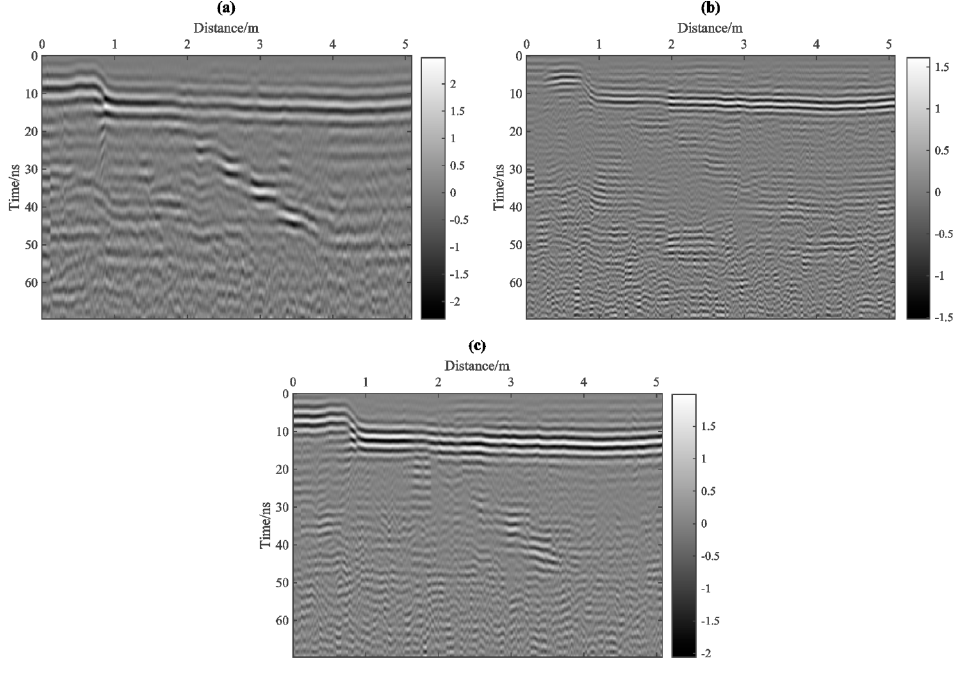
Figure 14. IMF-slices of the field data using MVMD. ( a − c ) show the IMF-slices 1 − 3, respectively. Based on the above IMF-slices, we derive the corresponding instantaneous amplitude profiles and TKEO-slices, as seen in Figures 15 and 16, where the phenomenon of the “low-frequency anomalies” can be observed. Specifically, the low - frequency TKEO - slice (i.e., Figure 16a) highlights the horizontal layers and voids and, in the medium - and high - frequency TKEO-slices, the energy for the voids gradually decays until it becomes very weak, as seen in Figure 16b,c. Figure 15 a–c are the classical instantaneous amplitude at- tributes for the IMF-slices showing the similar features in lower resolution. It is obvious that the TKEO-slices are less disturbed by the noise and multiple reflections at the deep part of the profiles, which show better performance in gathering the energy at the location of voids. For comparative analysis, we apply the VMD to each A − scan of the field data, and then collect the IMFs of same order into three IMF-slices ( K = 3), as seen in Figure 17. The drawback of the trace − by − trace decomposition scheme is obvious, e.g., the discontinuity between adjacent traces due to misaligned frequency modes, marked by the red arrows between 3~4 m. The results of the TKEO computation based on the VMD − based IMF-slices are shown in Figure 18, where the resolution and lateral continuity is affected by the in- complete decomposition of VMD. The above application on the field data shows that the proposed method has an obvious response to the anomaly targets in the subsurface me- dium, and proves the effectiveness of the TKEO in gathering energy and suppressing mul- tiple reflections.